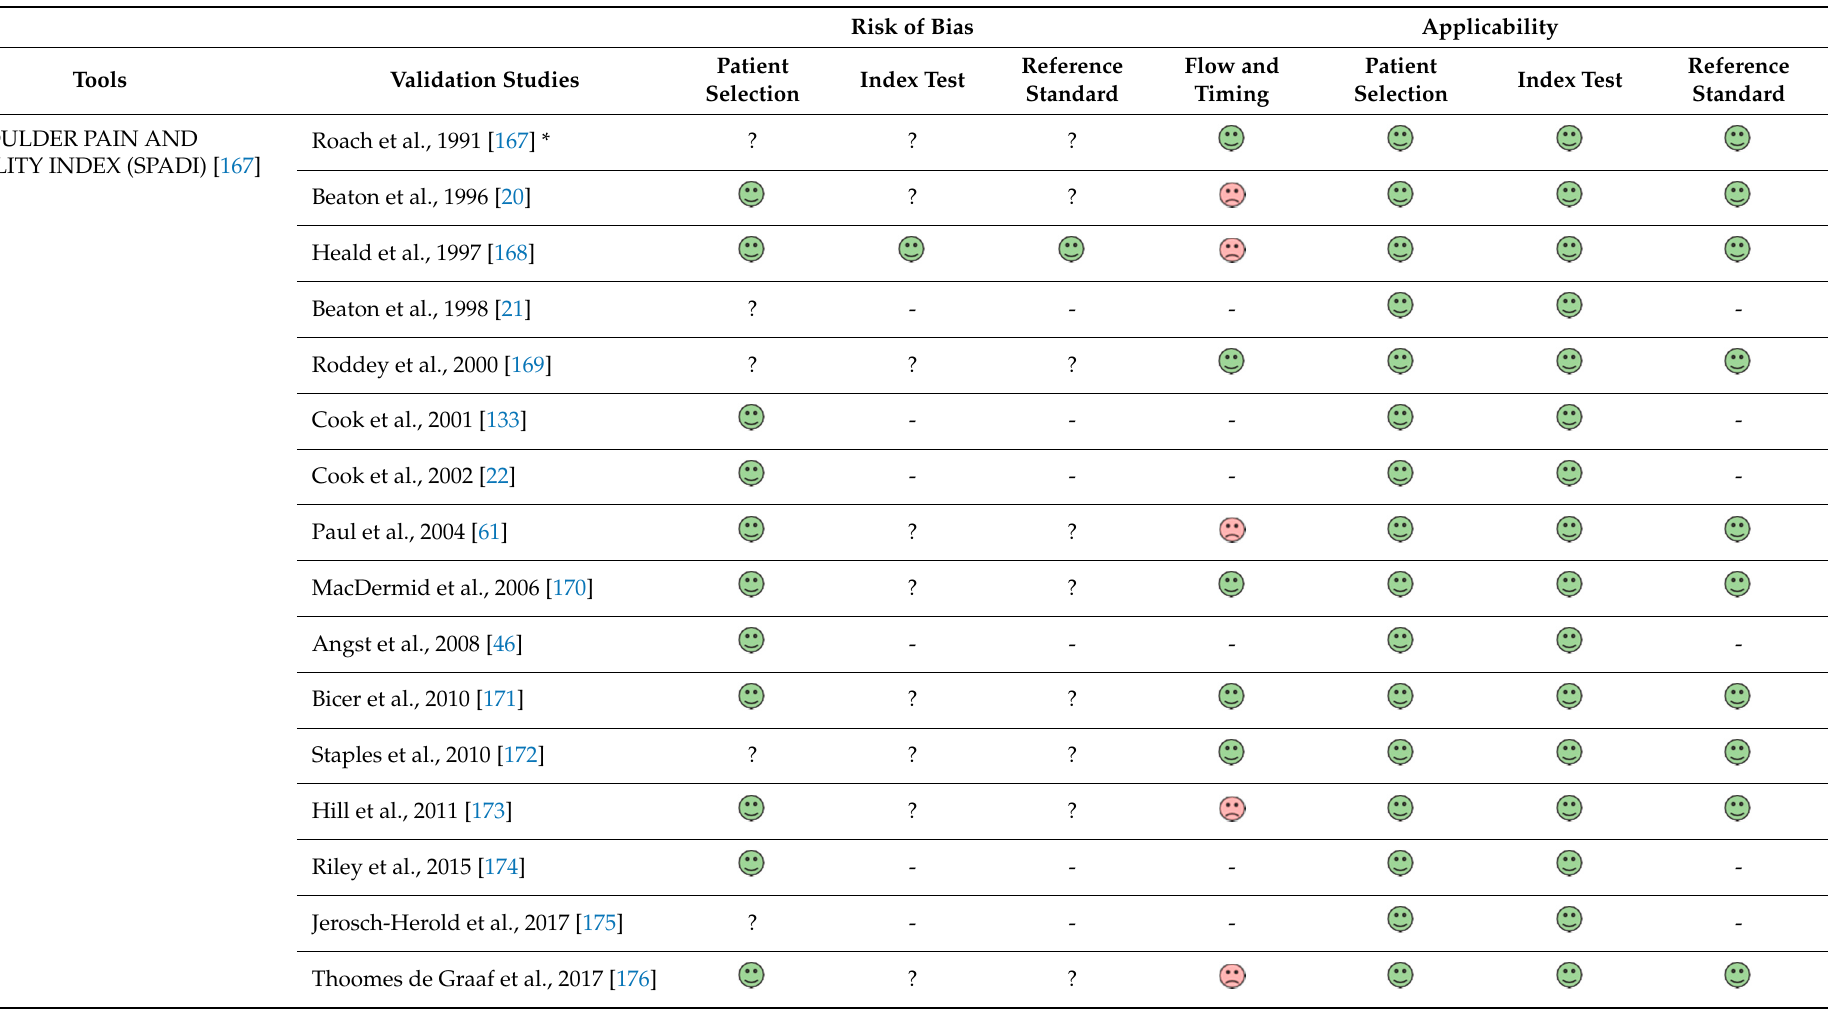
Table 3. Assessment of the methodological quality with QUADAS ‐ 2.